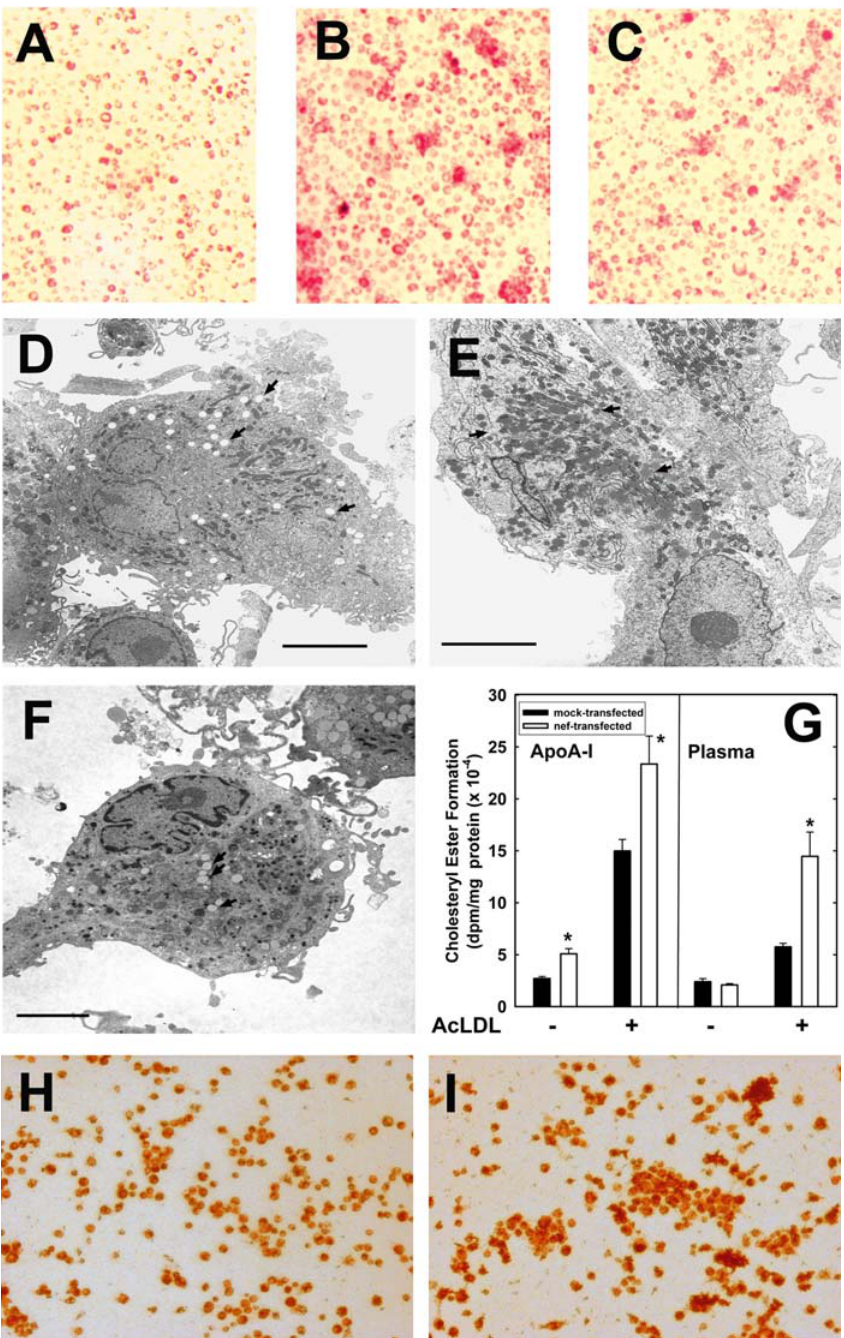
Figure 6. Accumulation of Lipids in Cells Infected with HIV-1 or Transfected with Nef (A–C) Oil Red O staining of HIV-infected macrophages. Uninfected (A) macrophages or cells infected with VSV-G–pseudotyped Nef-positive (B) or D Nef (C) HIV-1 SF2 variants were loaded with cholesterol on day 3 after infection by incubating with AcLDL in the presence of apoA-I, and lipids were stained with Oil Red O 24 h later. p24 concentration in the culture supernatant on day 3 after infection was 4.7 ng/ml for cells inoculated with Nef-positive virus and 9.8 ng/ml for the culture inoculated with D Nef HIV-1. (D–F) Electron microscopy of cholesterol-loaded uninfected macrophages (D) and cells infected with Nef-positive (E) and D Nef (F) HIV-1 AD8 performed 14 d after infection. Uninfected cells have small numbers of electron-lucent lipid vacuoles (arrows). The cytoplasm of cells infected with Nef-positive virus is filled with electron-dense lipid vacuoles (arrows). Cells infected with D Nef virus have small numbers of electron-lucent lipid vacuoles (arrows), similar in number to those in uninfected cells. The scale bars represent 5 l m. (G) The effect of Nef on cholesteryl ester synthesis. The rate of cholesteryl ester synthesis in RAW 264.7 cells transfected with an empty vector (mock- transfected) or Nef-expressing construct and incubated with or without AcLDL in the presence of apoA-I or 5% human plasma is presented as mean 6 SD of quadruplicate determinations. An asterisk (*) indicates p , 0.02. (H) and (I) RAW 264.7 cells were transfected with empty vector (H) or Nef-expressing construct (I), stimulated with LXR agonist, incubated with AcLDL and lipid-free apoA-I, fixed with formaldehyde, and stained with Oil Red O. DOI: 10.1371/journal.pbio.0040365.g006